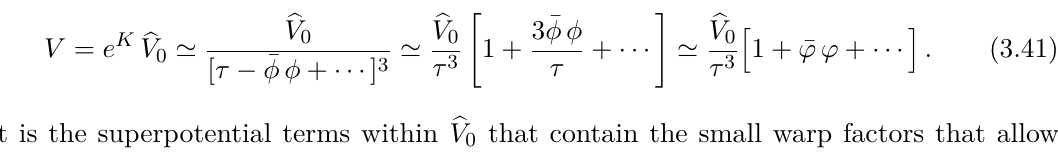
Figure 2 . The Coulomb potential from the superpotential w reproduces the Coulomb interaction for large values of the brane separation φ but at smaller distances the interaction potential has a minimum and becomes repulsive. At large field values, and due to the large amount of warping the potential is flat enough to give rise to inflation in a natural way. The minimum of the potential lies outside the domain of validity of the EFT and only for large values of φ is this potential under